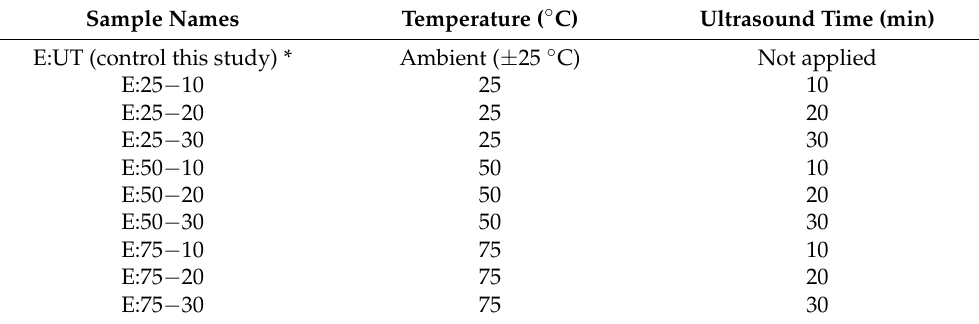
Table 1. Process conditions for obtaining red propolis extracts with or without